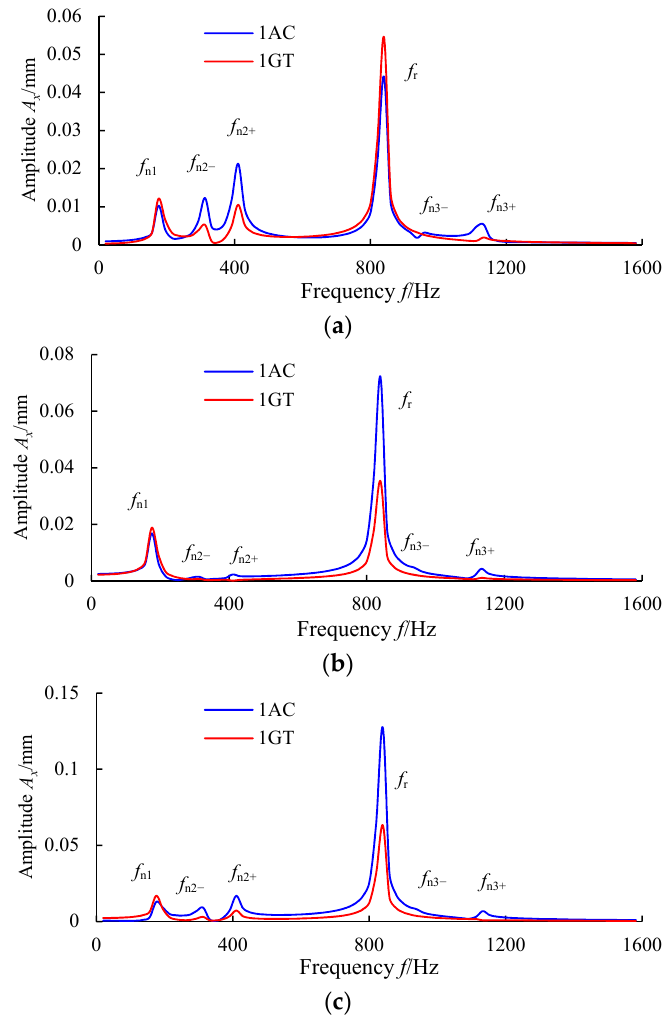
Figure 22. Transient response (0.05 ≤ t ≤ 0.12 s) in frequency domain for the blade off occurring at two different locations: ( a ) 1# bearing; ( b ) node 11 (C.G. position); ( c ) 2# bearing.